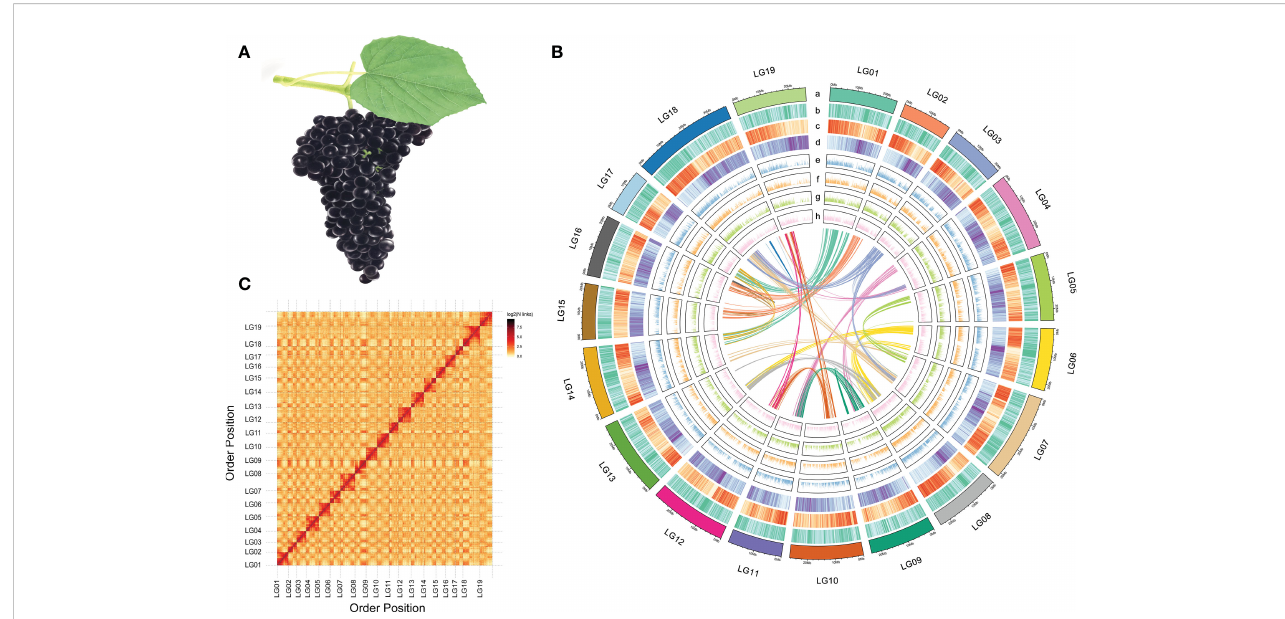
FIGURE 1 Morphology and genome information of V. adenoclada . (A) Drawing of V. adenoclada specimens. (B) Landscape of the V. adenoclada genome. a: chromosome ideograms; b: GC density; c: gene density; d: TE density; e~h: gene expression levels of YN2, GH4, GH5, and GH6, respectively; center: syntenic blocks within the genome. (C) Hi-C interaction heatmap of V. adenoclada